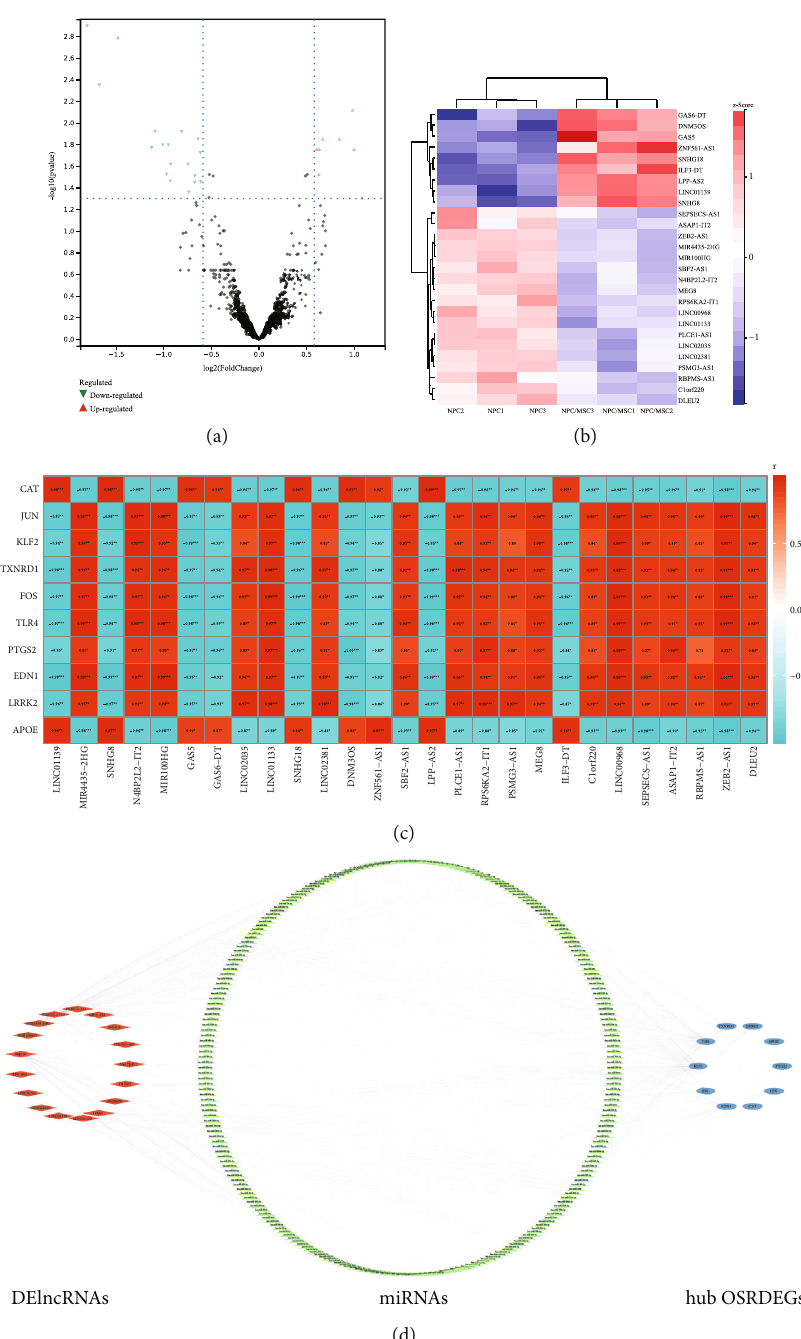
Figure 5: Construction of ceRNA regulatory network. (a) Volcano plot of DElncRNAs; (b) Heat map of DElncRNAs; (c) Correlation analysis between hub OSRDEGs and DElncRNAs; (d) The ceRNA regulatory network containing 17 DElncRNAs, 240 miRNAs, and 10 hub